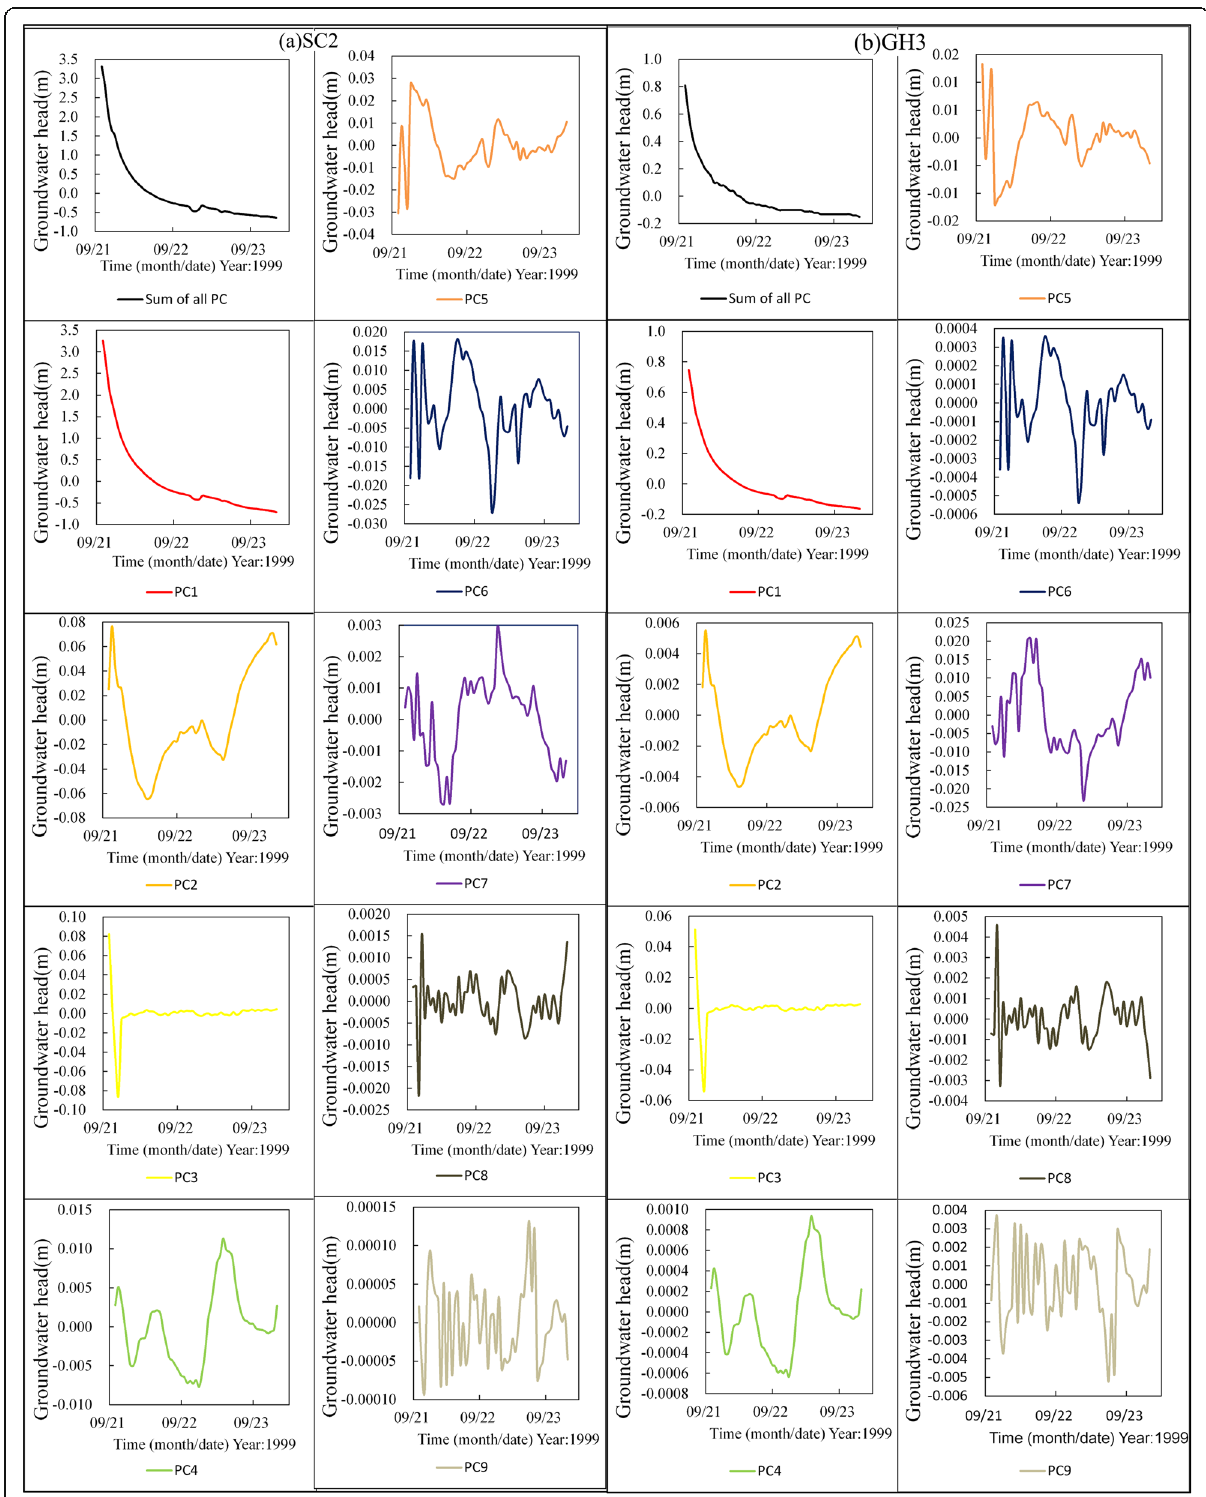
Fig. 12 The decomposed post-seismic drawdown hydrograph in groundwater head across multiple principal components in a SC2 and b GH3 monitoring zone by using